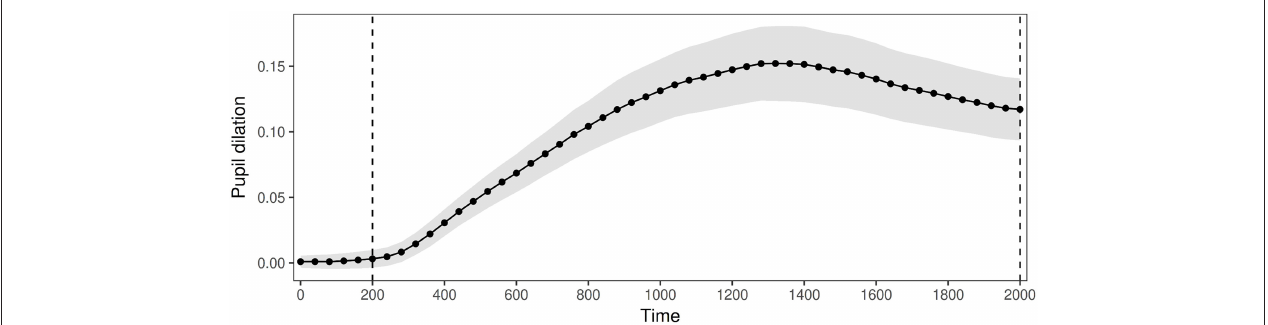
FIGURE 1 | Time-course of pupil dilation. Zero ms represents onset of the auditory stimulus. Shaded bands represent 95% simultaneous confidence intervals. Vertical lines at 200 and 2,000ms indicate the subsequent analysis